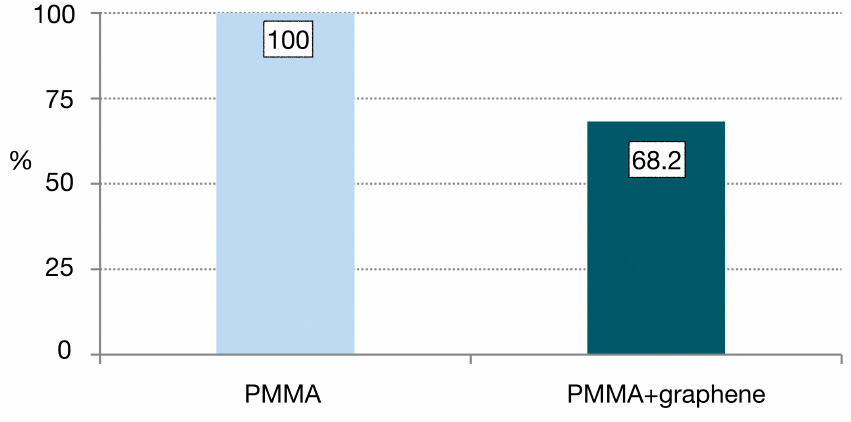
Figure 4. Incidence of restorations that resist 120,000 fatigue cycles.